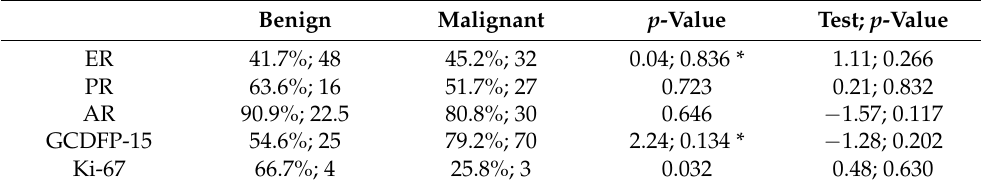
Table 6. Expression of hormone receptors according to the nature of the treated